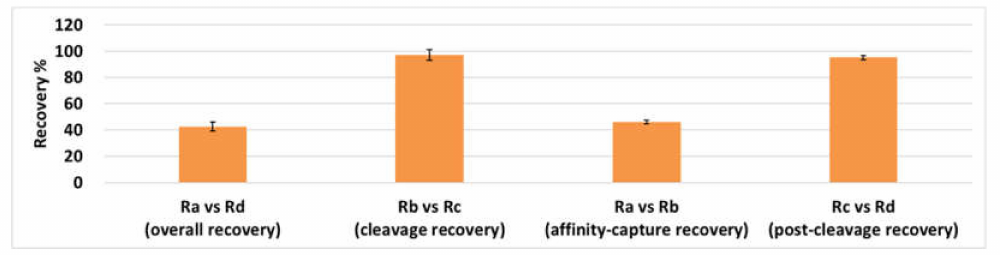
Figure 3. Recovery of sample preparation steps for acDrug analysis.